Question: What kind of plot is shown here?
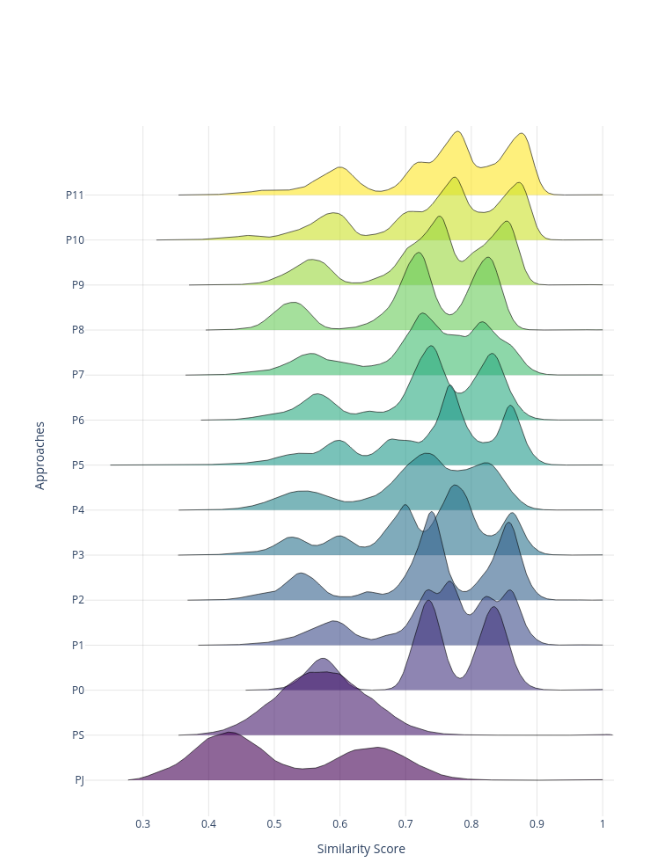
Answer: histogram